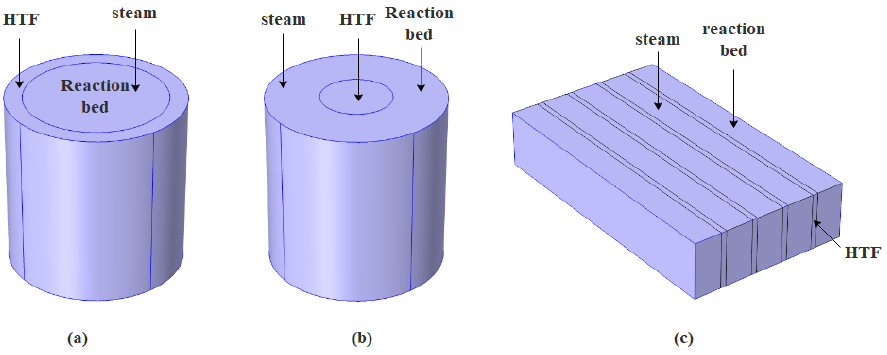
Figure 1. Indirect heat exchange structure of the Ca(OH) 2 /CaO thermochemical energy storage reactor. ( a ) External flow of the tubular reactor. ( b ) Internal flow of the tubular reactor. ( c ) Plate fin heat sinks (PFHS) reactor.